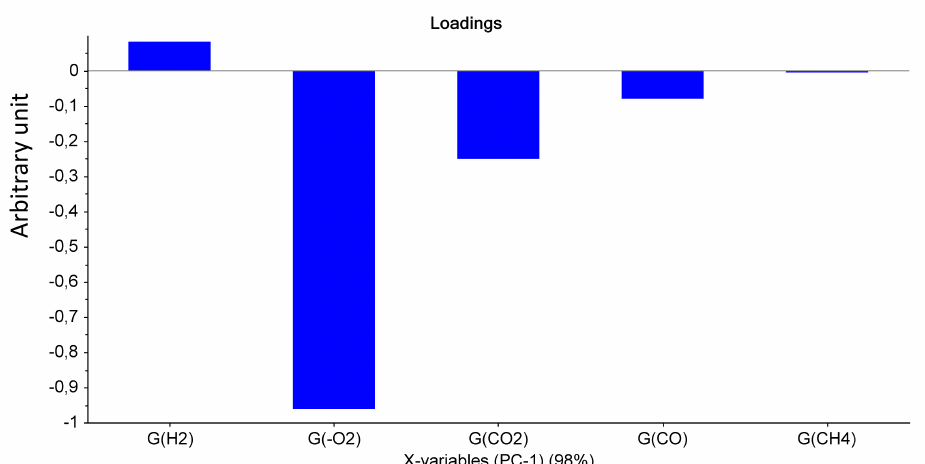
Figure 7. PC1 (98% of the variance) results on Mod4: first irradiation doses (kGy) with dose rates (Gy/h).